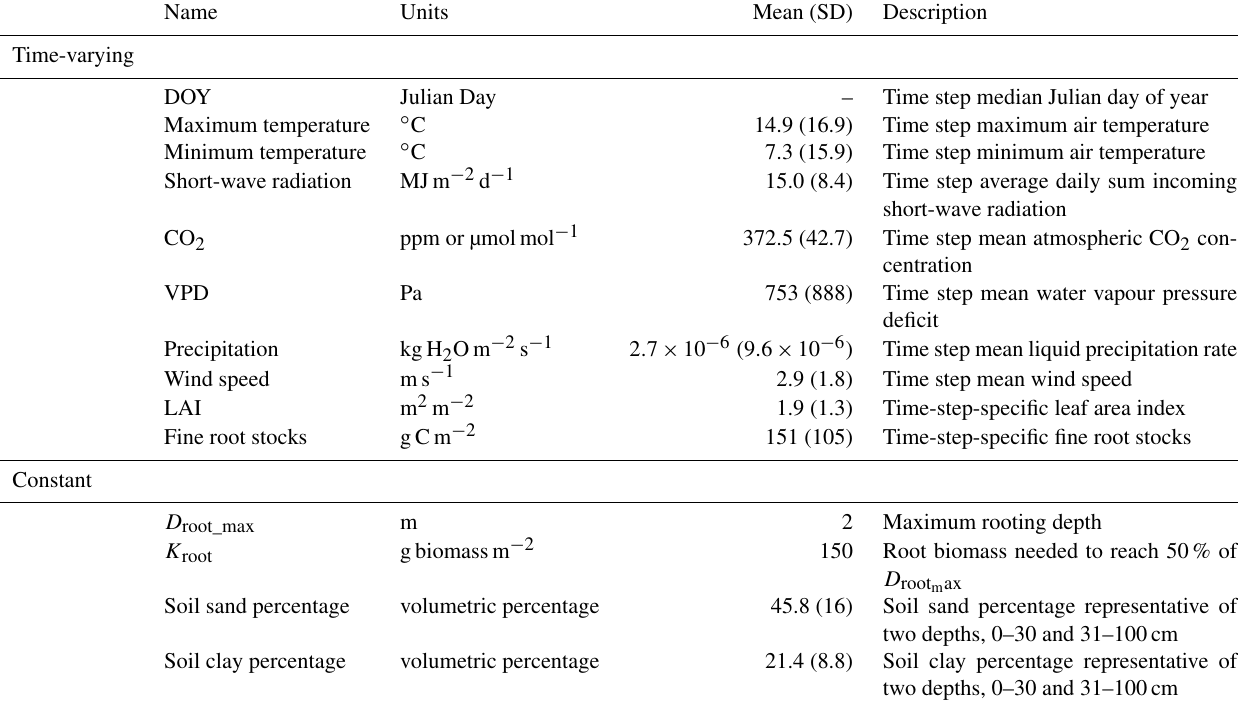
Table 1. Drivers required as inputs by ACM-GPP-ET. Each driver has its unit specified and a brief description. The mean value across the calibration climate space is given with the standard deviation in parentheses. The drivers are divided between those which are time-varying and those assumed constant for a given location but that can vary between